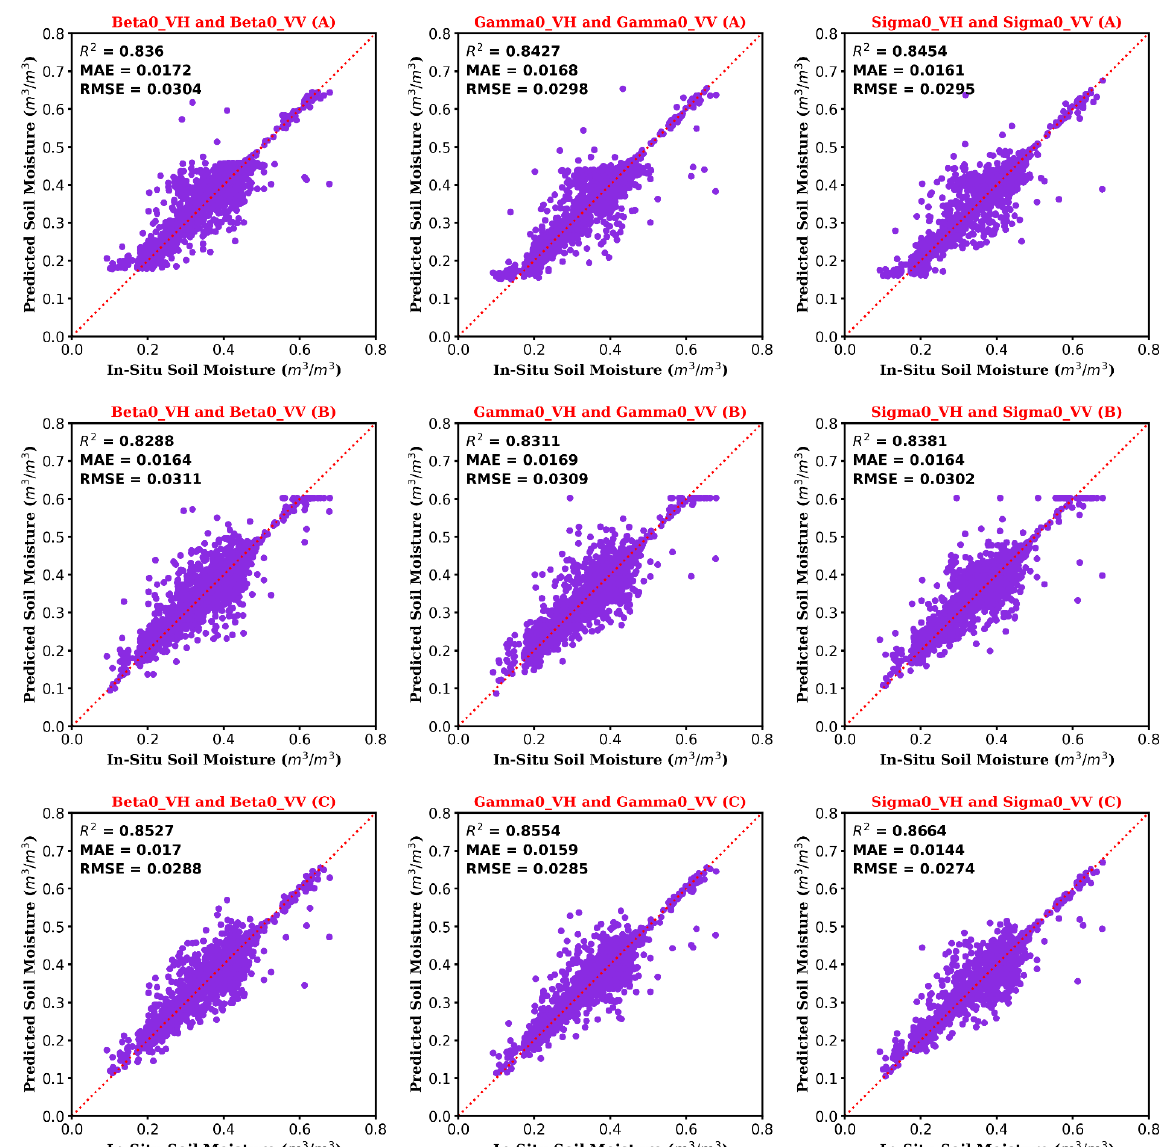
Figure 4. The prediction performance of the CNN architecture ( A ), CNN architecture ( B ), and CNN architecture ( C